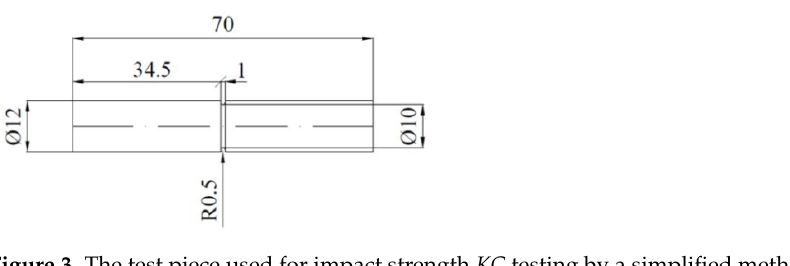
Figure 3. The test piece used for impact strength KC testing by a simplified method (dimensions in millimeters) [47].